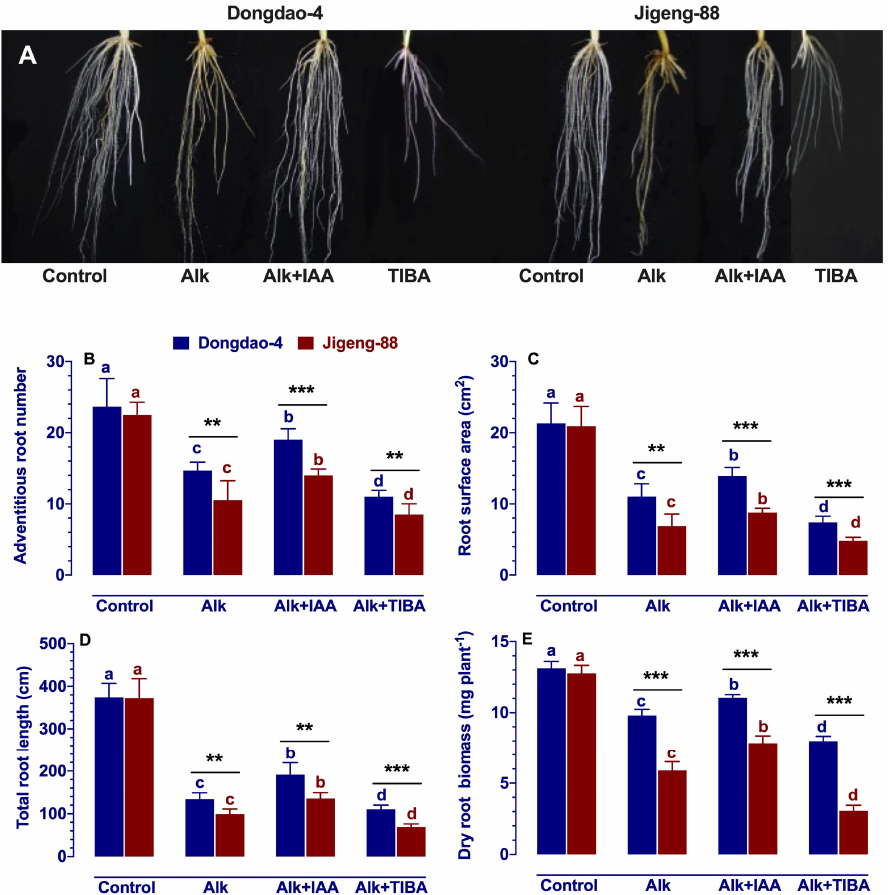
Figure 4. Effects of IAA and TIBA on ( A ) root symptoms, ( B ) adventitious root number, ( C ) root surface area, ( D ) total root length, ( E ) dry root biomass of Dongdao-4 and Jigeng-88 seedlings after treatment with alkaline stress. Treatments were as described in Figure 1. Means with different letters are significantly different ( p < 0.05) between control and “Alk” and “Alk + IAA” and “Alk + TIBA” of the same genotype. Asterisks indicate significant differences between different genotypes within the same treatment (** p < 0.01, *** p < 0.001).